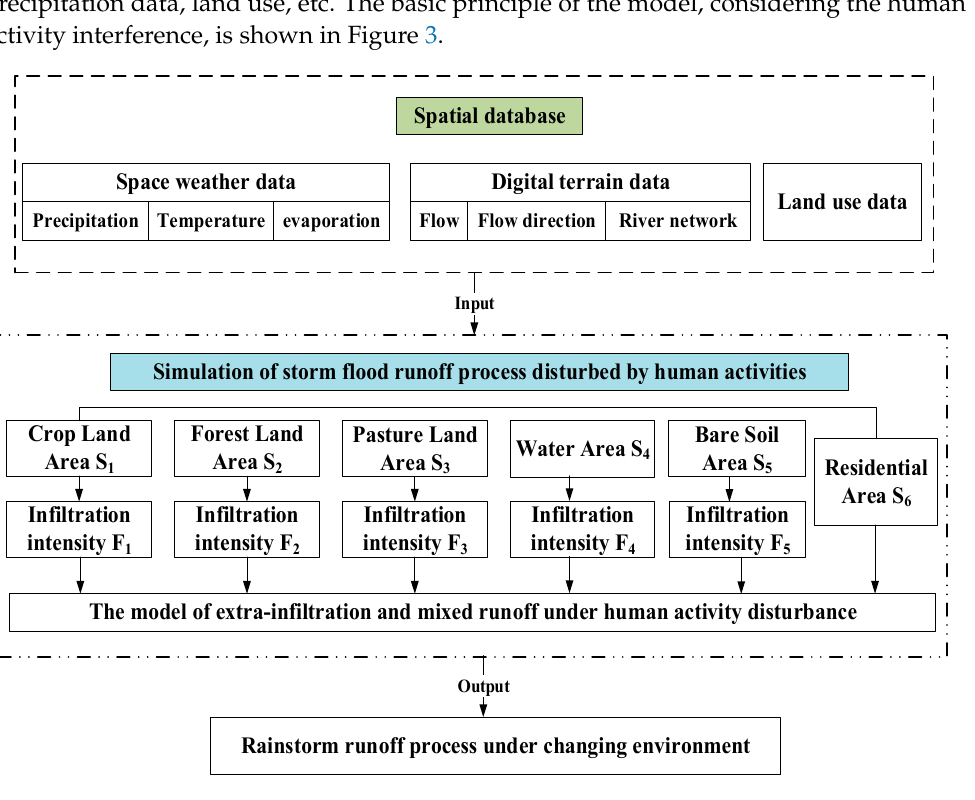
Figure 3. MCDRM model structure and schematic